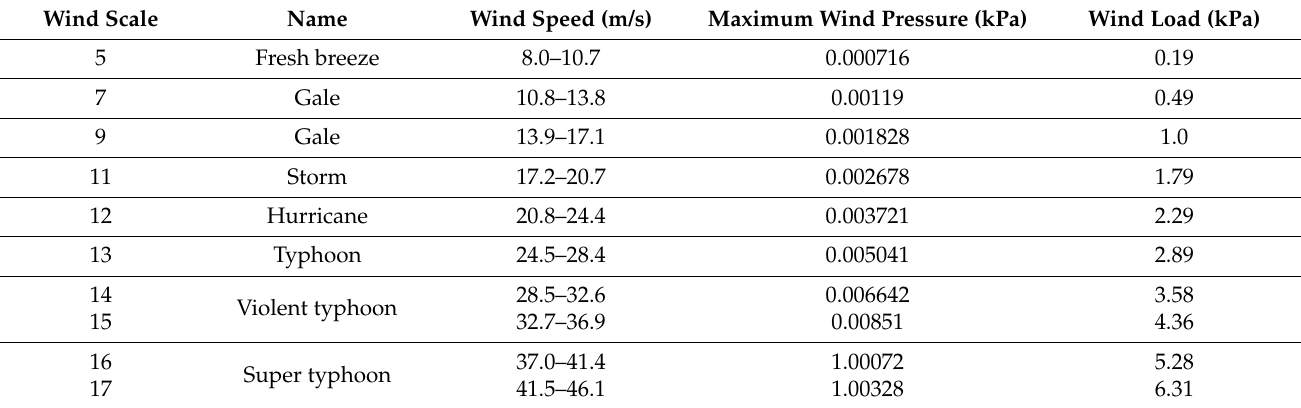
Table 3. Comparison table of wind level, wind speed, and wind load.